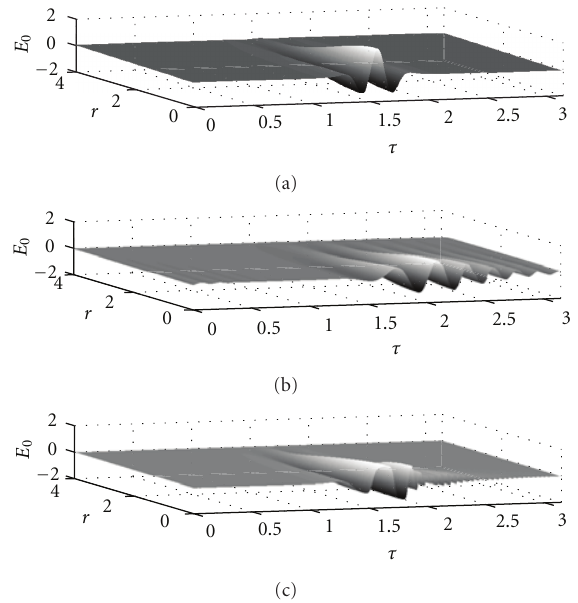
Figure 1: Evolution of a narrow pulse (a) for large ( B = 0 . 1, (b)) and small ( B = 0 . 0001, (c)) normal dispersion at early stages ( z = 0 . 2). In the latter case, the profile steepens, corresponding to the generation of higher frequency components.